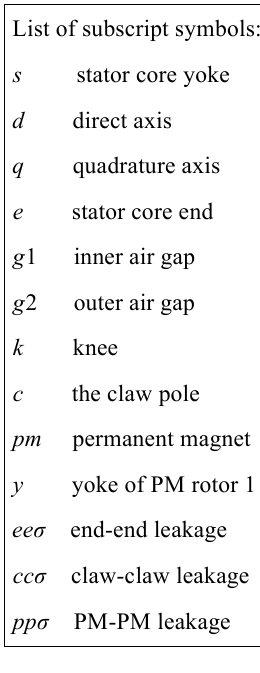
Figure 6. Equivalent magnetic circuit diagrams with load: ( a ) d-axis; ( b )